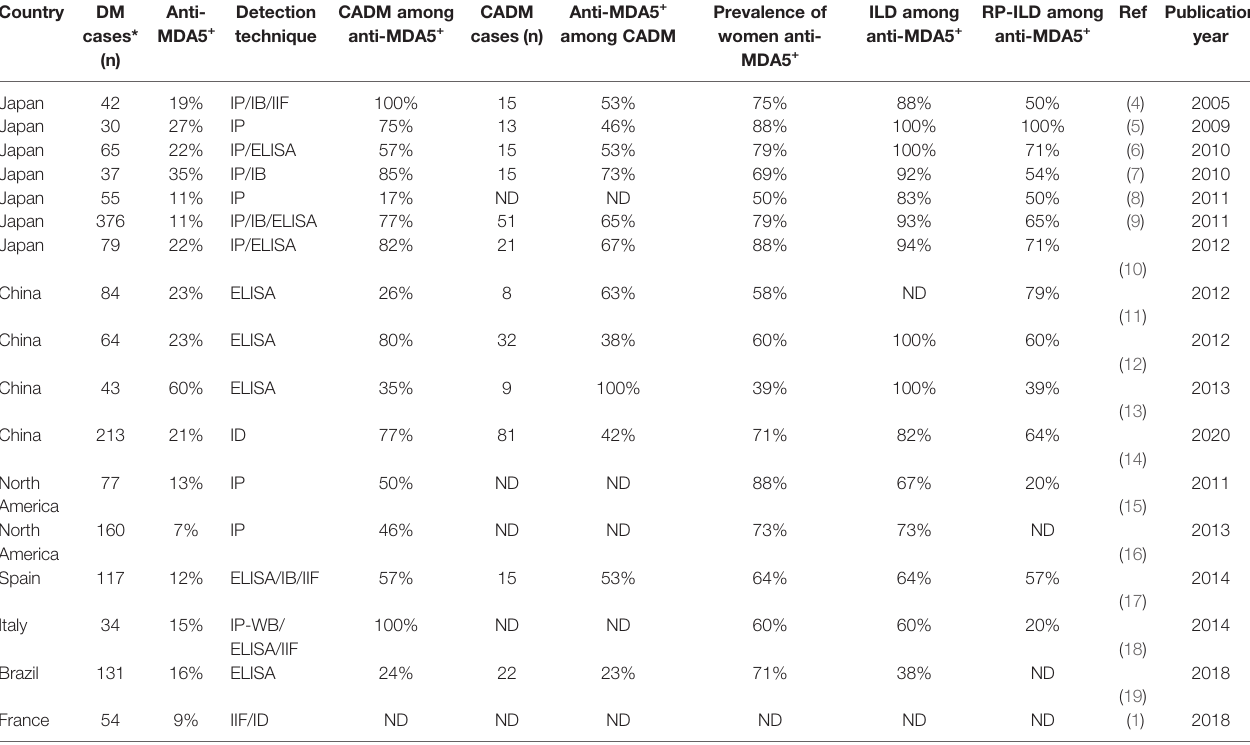
*Selection of cohorts with at least 30 patients (cohorts with JDM patients excluded). DM, dermatomyositis; CADM, clinically amyopathic dermatomyositis; JDM, juvenile dermatomyositis; ILD, interstitial lung disease; RP-ILD, rapidly progressive interstitial lung disease; IP, immunoprecipitation; IB, immunoblot; IIF, indirect immuno fl uorescence; ELISA, enzyme-linked immunosorbent assay; WB, western blot; ID, immunodot assay; ND, not